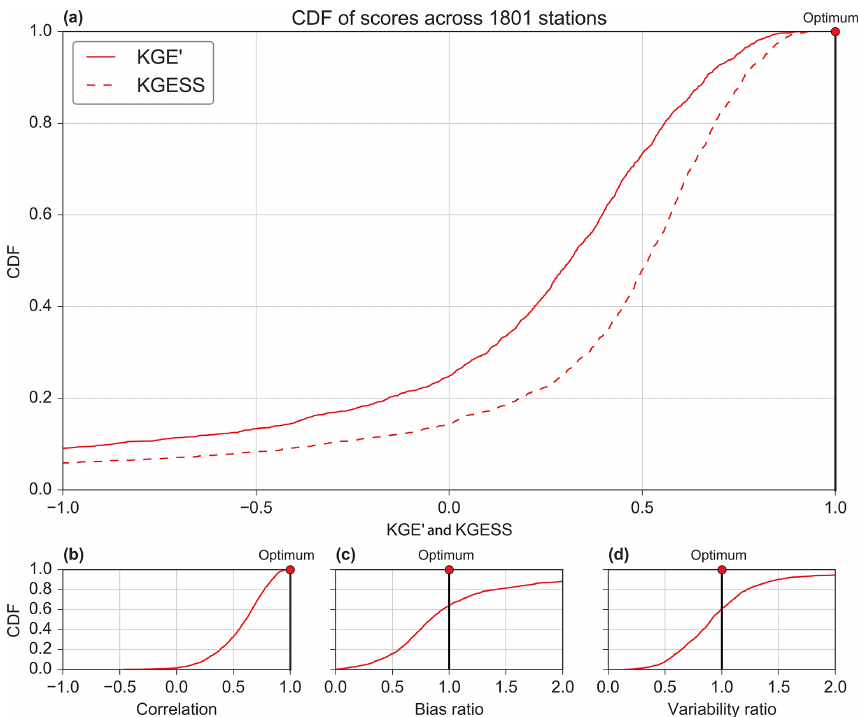
Figure 4. Cumulative distribution function (CDF) of performance metrics across all 1801 stations. Modified Kling–Gupta efficiency (KGE (cid:48) ) and skill score (KGESS) (a) with decomposition of KGE (cid:48) into Pearson correlation (b) , bias ratio (c) , and variability ratio (d) . The red dot marks the optimum value for each metric.